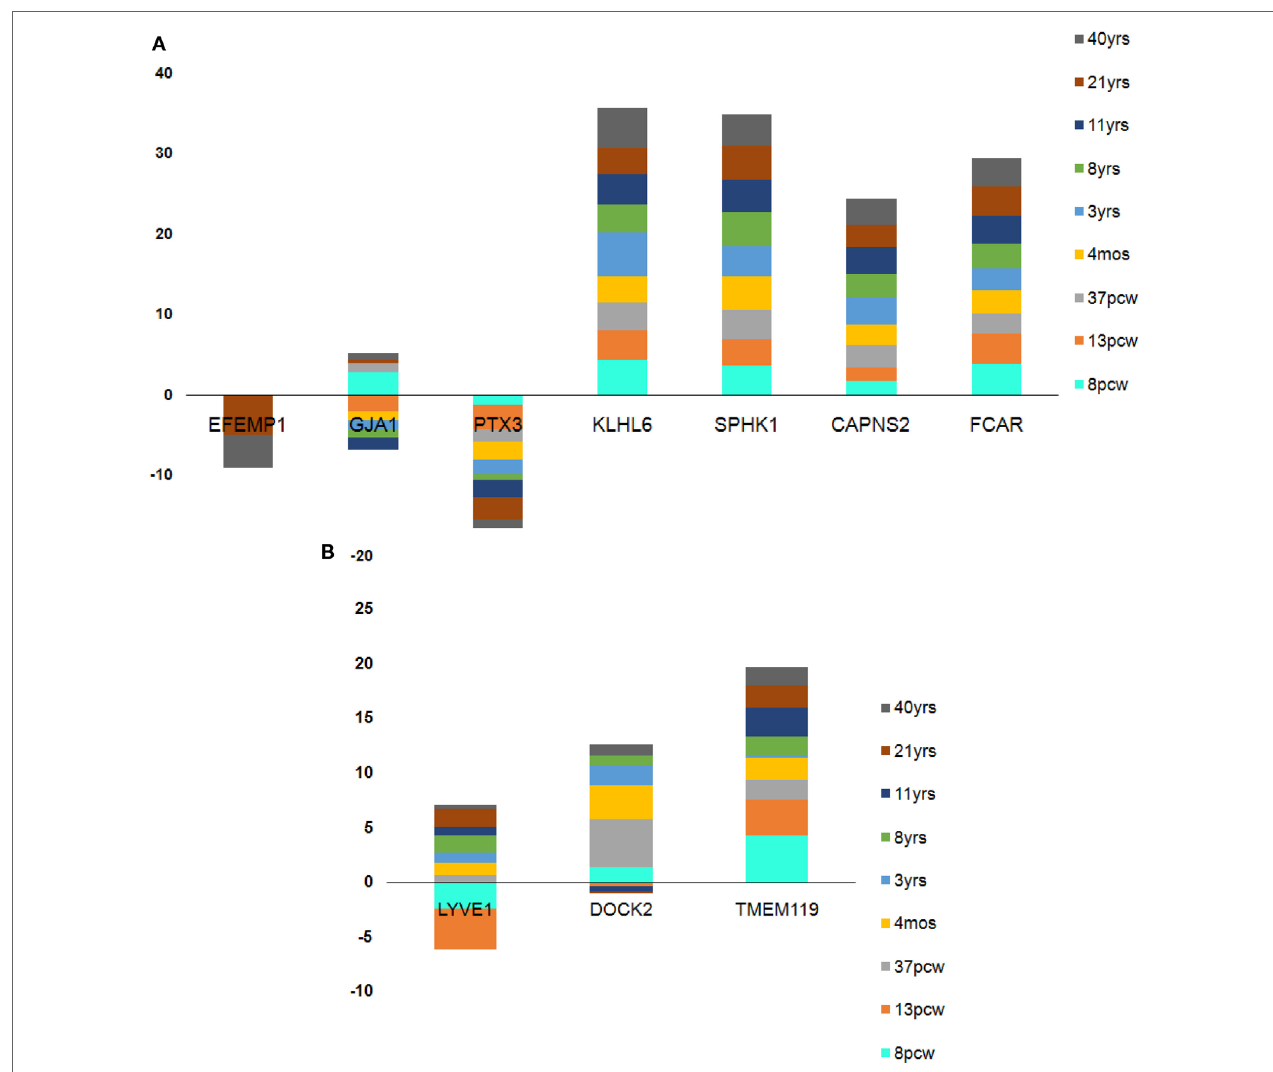
FigUre 8 | Age-wise dynamics yielded crucial microglia-specific signatures. (a) Seven genes found to be consistently high in expression from pre- to prenatal brain developmental stages. (B) Three genes found to be dynamically expressed with sharp dips at the transition stage of 37 postconception week (pcw) except in case of DOCK2 which was inconsistently expressed throughout pre- and postnatal stages. Each stack in the stacked bar plot represents a single brain age whose height denotes the amount of expression. FigUre 9 | Brief scheme demonstrating the protocol of directed differentiation of hESCs into human microglia which is characterized by several stage-specific markers.